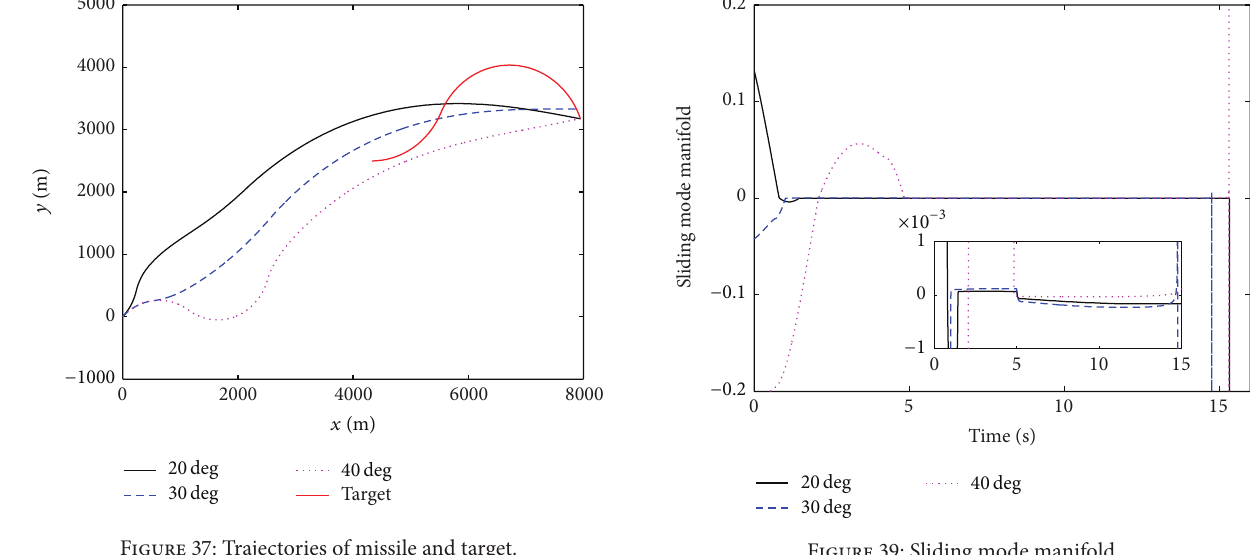
Figure 39: Sliding mode manifold.